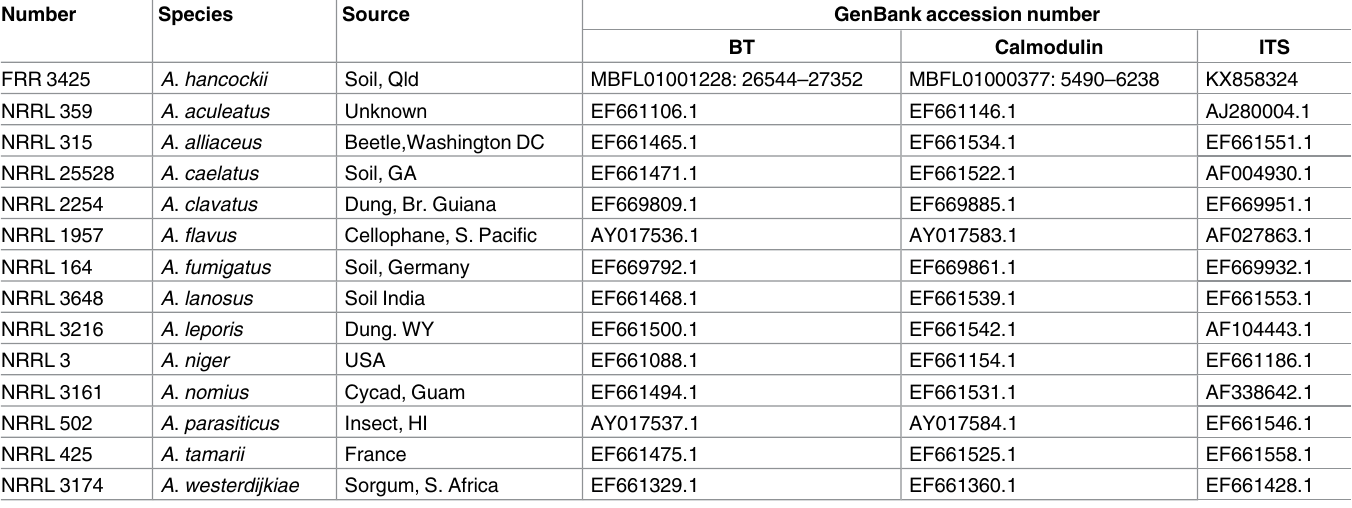
Table 1. Strains used in phylogenetic